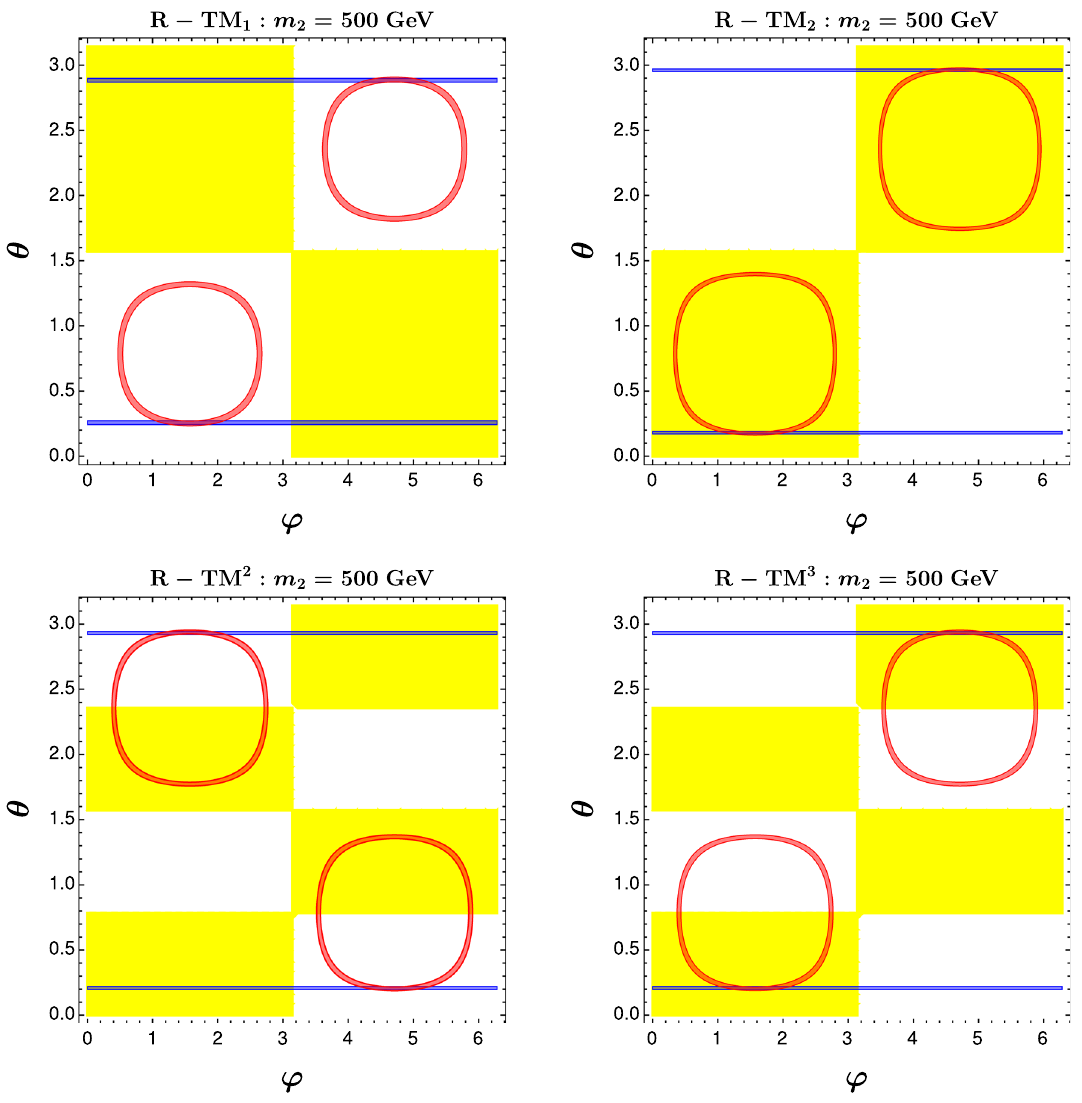
Fig. 5 Allowed regions for the two mixing parameters, (θ,ϕ) , under as well as the PMNS matrix element | U 13 | (narrow blue bands) in neu- the individual constraint from a positive baryon-number asymmetry trino oscillations [33]. Note that the yellow bands are independent of < 0 (red regions), (yellow bands), a negative CP measure J = J max the mass parameter m 2 chosen around the electroweak CP